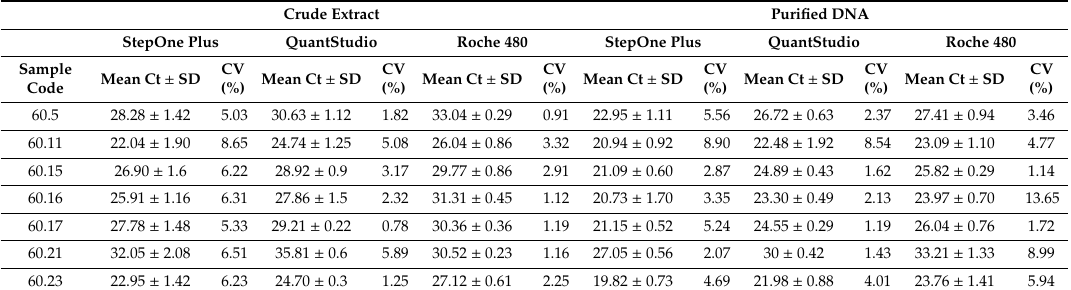
Table 3. Repeatability and reproducibility of the real-time qPCR method. Each sample was analyzed in nine technical repeats in three di ff erent thermal cyclers (three repeats per instrument), testing both crude extracts and purified